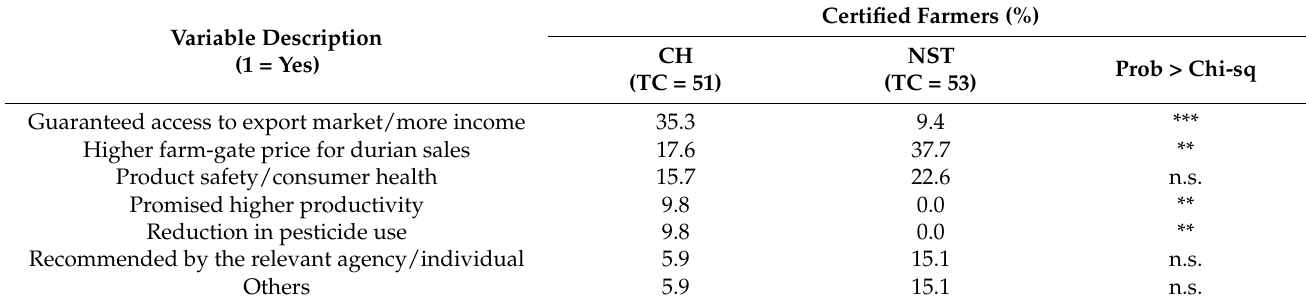
Table 2. Certified farmers’ motivation in applying for